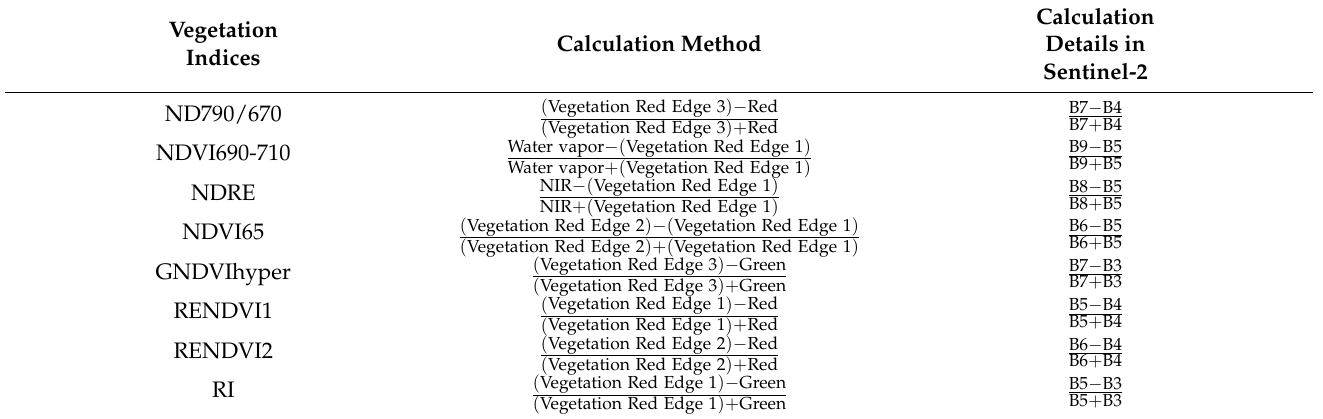
Table 4. Method for calculating the 8 new vegetation indices related to red edge.